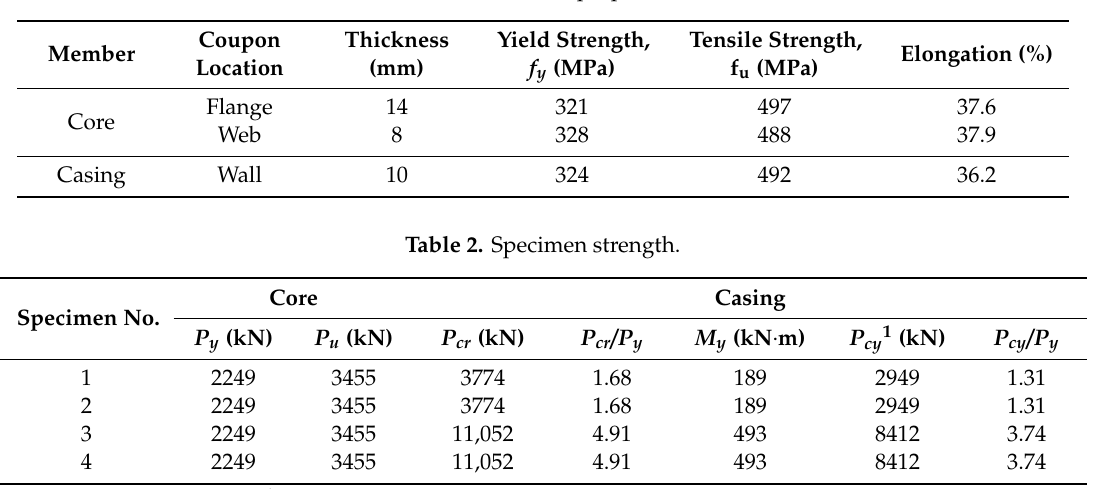
Table 1. Material properties.